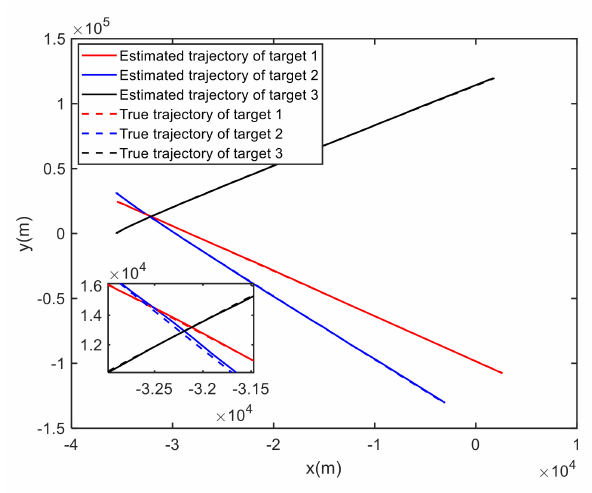
Figure 12. True and estimated tracks using the RL-JPDA in Case 1.